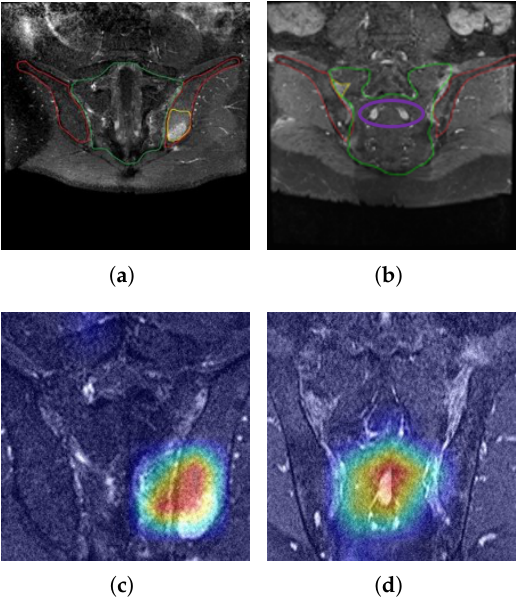
Figure 8. ( a ) Results of the class activation mapping for an example image with bone marrow edema; ( b ) Another example of an image with markers for bone marrow edema; ( c ) Gradient-based class activation map of ( a ); ( d ) Gradient-based class activation map of ( b ). The color represents regions with the greatest activation, and the degree of activation decreases in the order of orange, yellow, green, and